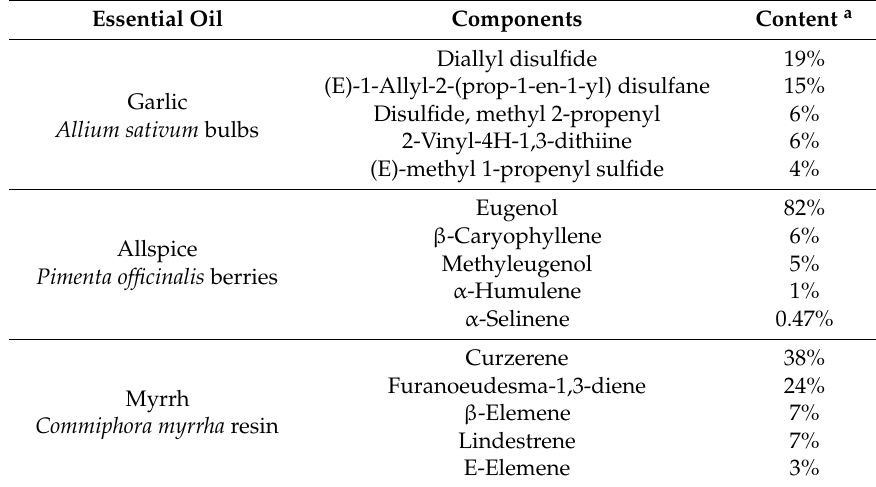
Table 3. The top five major compositions of the three most active essential